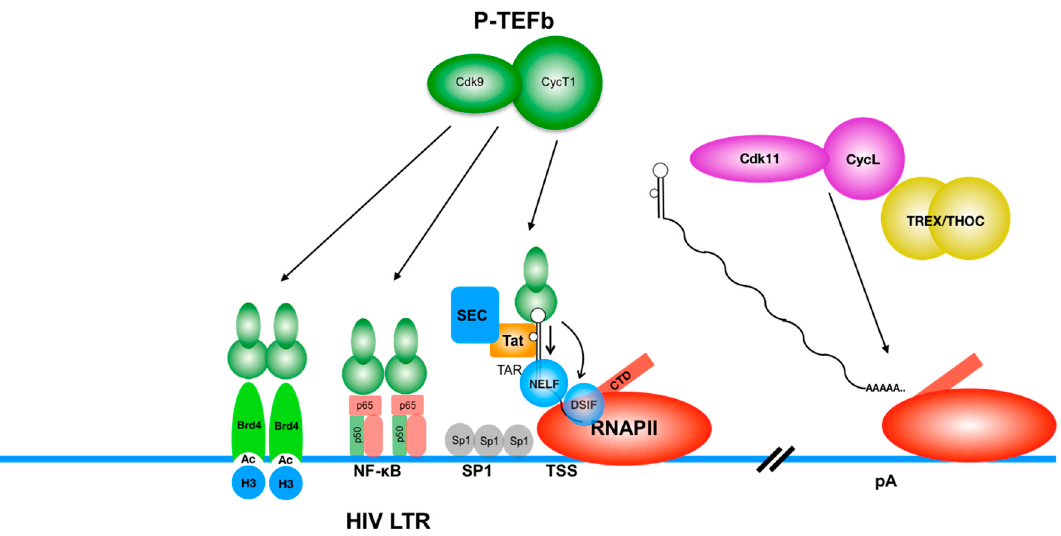
Figure 1. Two major cellular cyclin / Cdk complexes play key roles in HIV transcription. P-TEFb (CycT1:CDK9, green) is recruited to the transcription machinery on HIV LTR by various factors. Epigenetic factor Brd4, DNA-bound transactivator NF κ B, and viral Tat (associated with cellular super elongation complex) bind to CycT1 and recruit P-TEFb to HIV provirus in an active chromatin environment. P-TEFb then phophorylates RNAPII and negative transcription elongation factors NELF and DSIF, which augments transcriptional elongation. CycL:Cdk11 complex (yellow), in turn, associated with transcription / export and THO complex (TREX / THOC) is recruited to RNAPII transcribing HIV genes. Cdk11 phosphorylates the CTD of RNAPII and promotes the assembly of cleavage and polyadenylation (CPA) factors at the 3 ′ end of genes, which ensures optimal expression of HIV mRNAs.